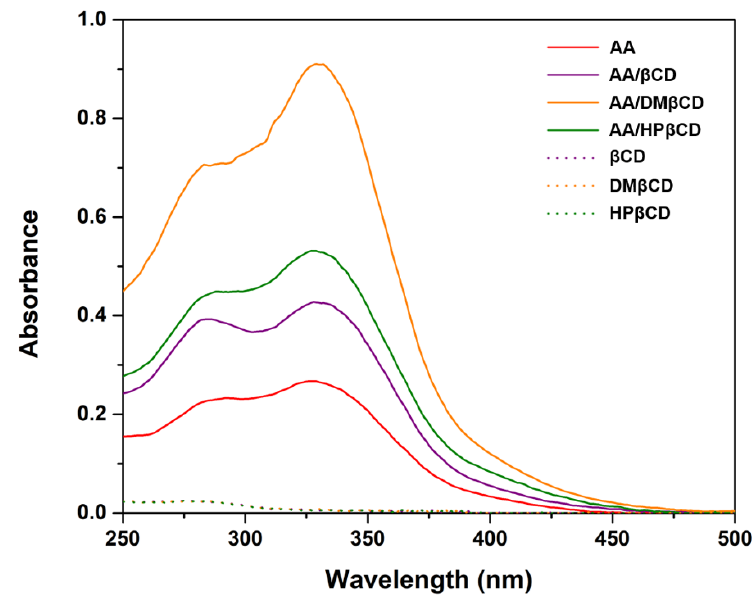
Figure 3. UV-Vis spectra of AA, inclusion complexes, and the free form of β CDs.